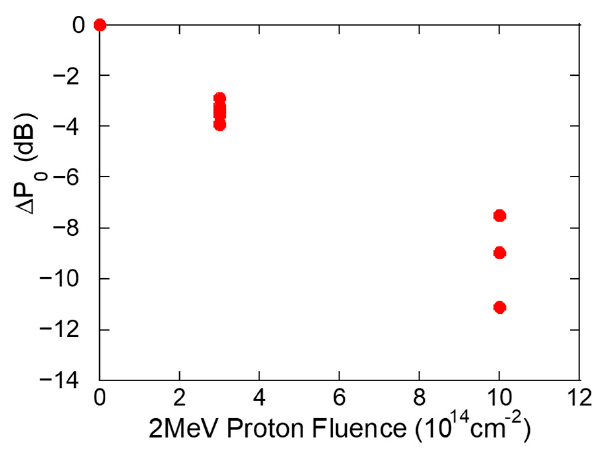
Figure 12. Change in output power of HEMT by 2 MeV proton irradiation.